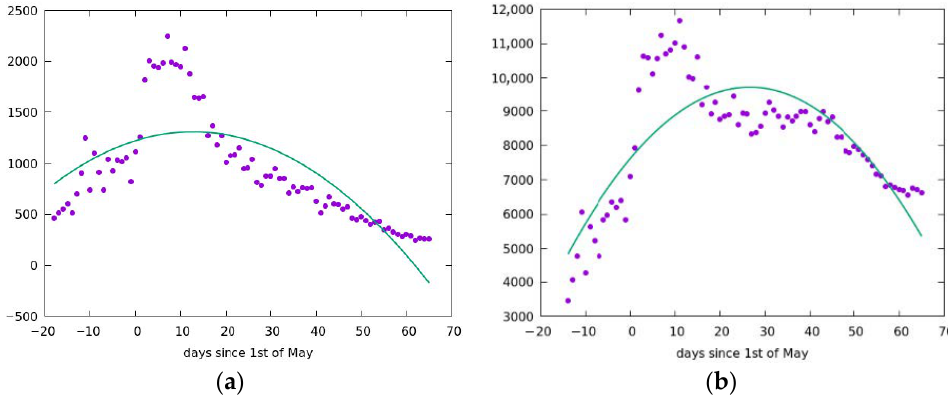
Figure 11. Maximums of infection for ( a ) the first band and ( b ) all of Russia that correspond to maximums of parabolas. For the first band ( a ) the maximum is near the point 13 which means May 14 and for all of Russia ( b ) it is near the point 28 which means May 29.